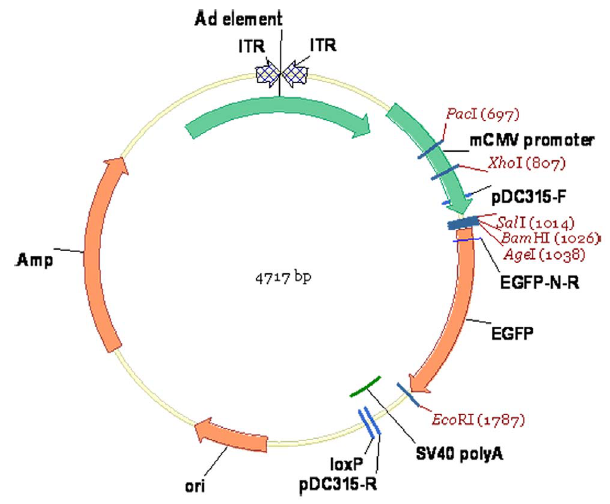
Figure 1. Schematic representation of the pDC315-EGFP plasmid is shown. ITR: inverted terminal repeat; Ad element: mouse 15-lipoxygenase-1 coding sequence; mCMV promoter: mouse cyto- megalovirus immediate early promoter; EGFP: enhanced green fluorescent protein; SV40 poly A: SV40 polyadenylation signal; loxP: Eukaryotic restructuring enzyme (Cre) restructuring recognition se- quence; Ori: E.coli origin of replication; Amp: ampicillin resistance